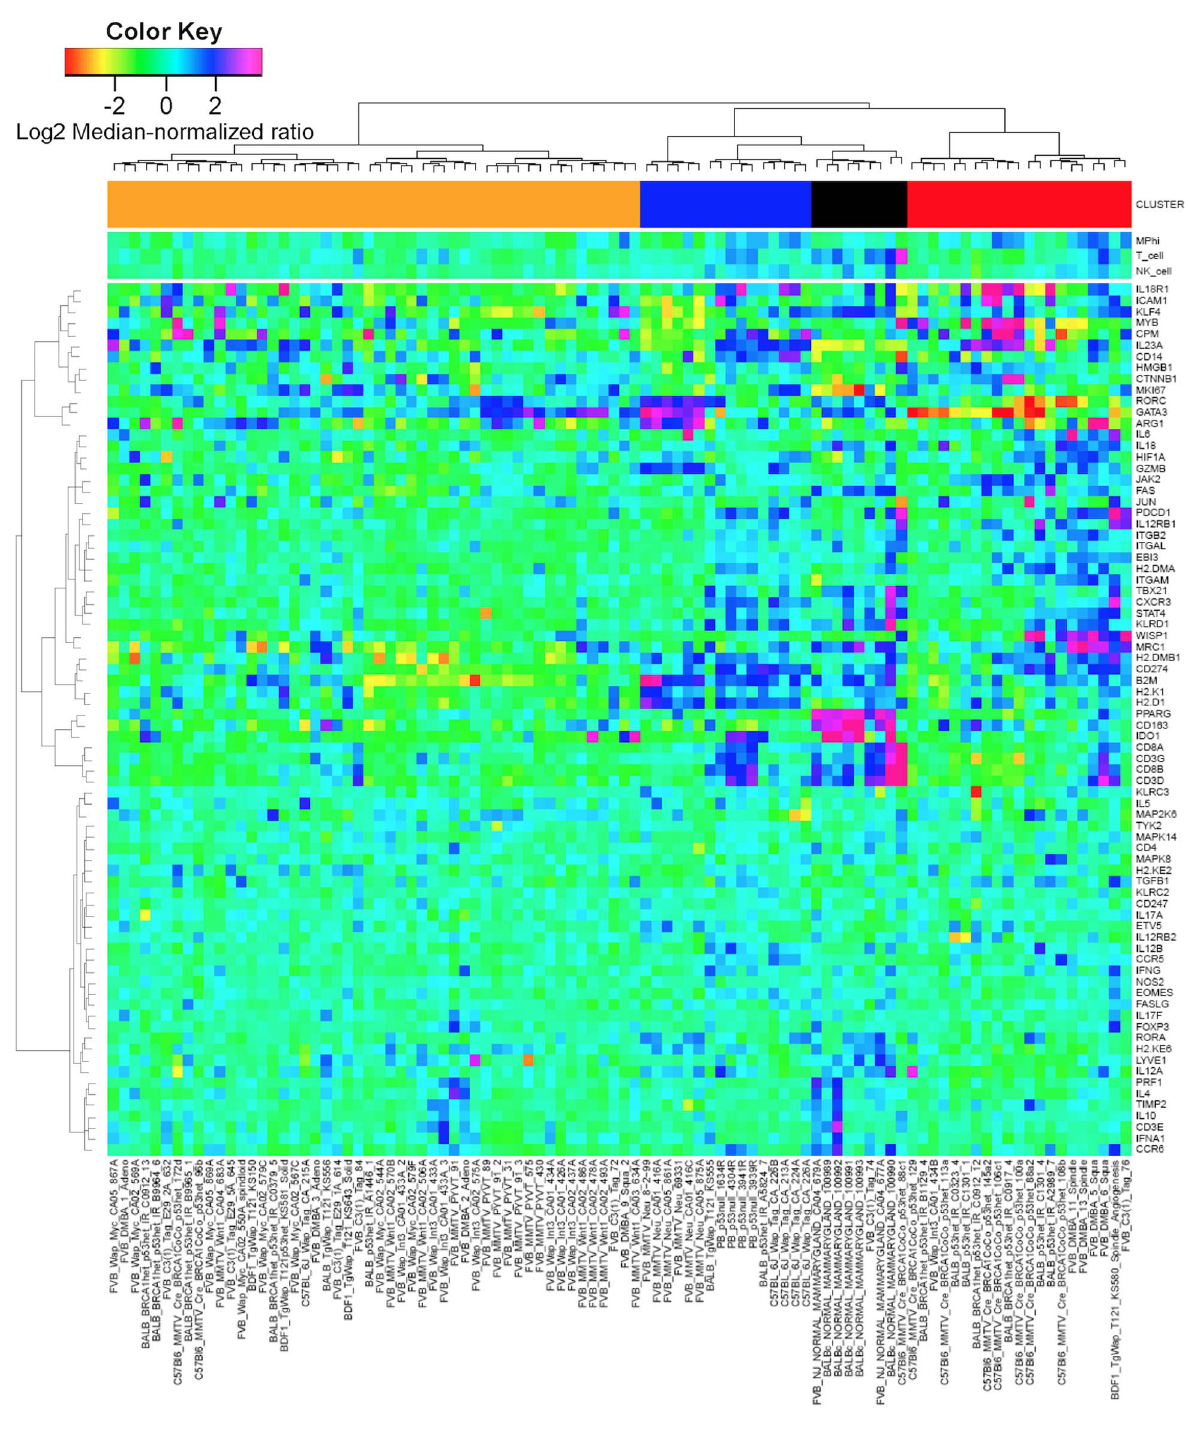
Figure 6. Immune gene expression signatures in genetically engineered mouse models for breast cancer clusters into three groups. mRNA expression obtained from normal and breast cancer carcinoma tissue samples derived from different genetically engineered mouse models (columns) were hierarchically clustered into four groups based upon the log2 median normalized expression ratio for genes (rows) related to cell- mediated cytotoxic immunity and tumor immunosuppression. The color-coded bar at the top of the heatmap indicates the four groups (Normals - black, Group 1 - blue, Group 2 - red, and Group 3 - orange). Gene expression is shown as a row-normalized heatmap, where red denotes under- expressed and violet denotes overexpressed relative to the population mean. Dendrogram indicates the degree of similarity among genes (rows) or samples (columns) using the Ward’s minimum distance method in R.